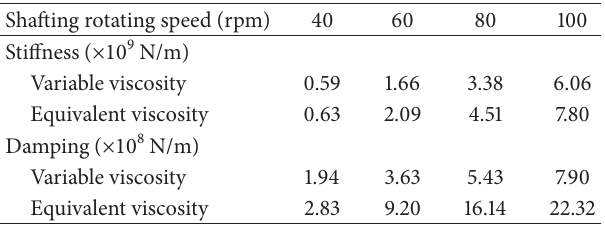
Table 2: Calculated stiffness and damping of oil film based upon equivalent viscosity and variable